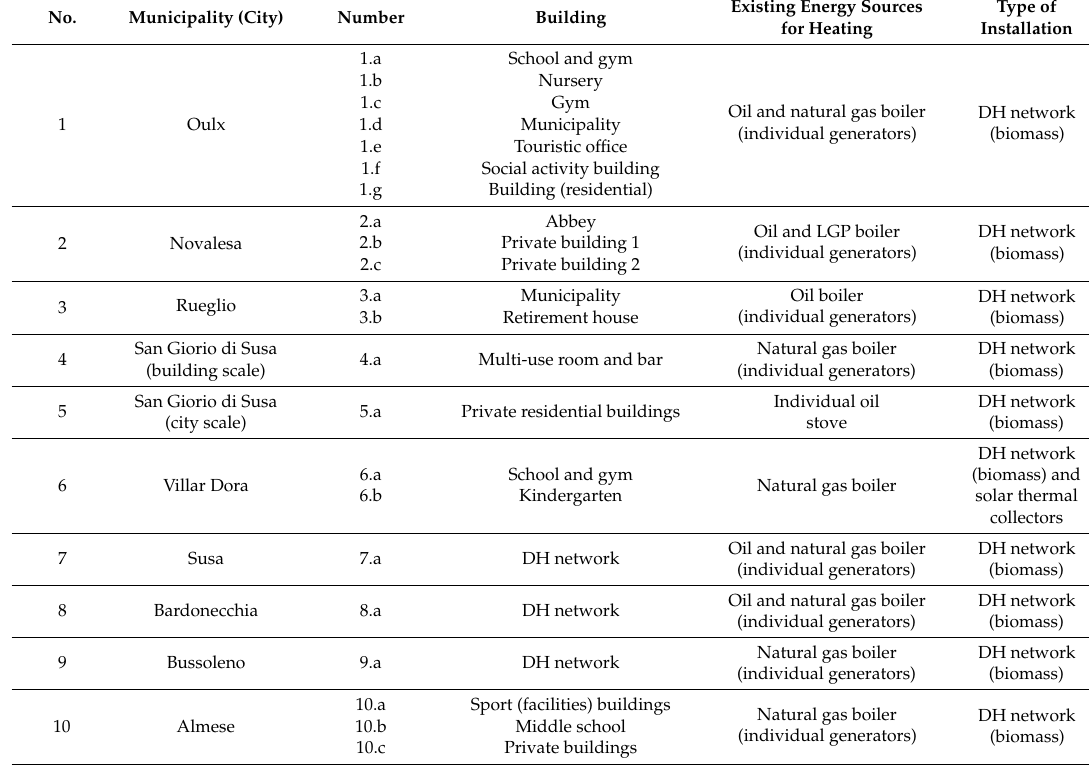
Table 1. Pilot case studies. DH: district heating; LGP: Liquid Propane